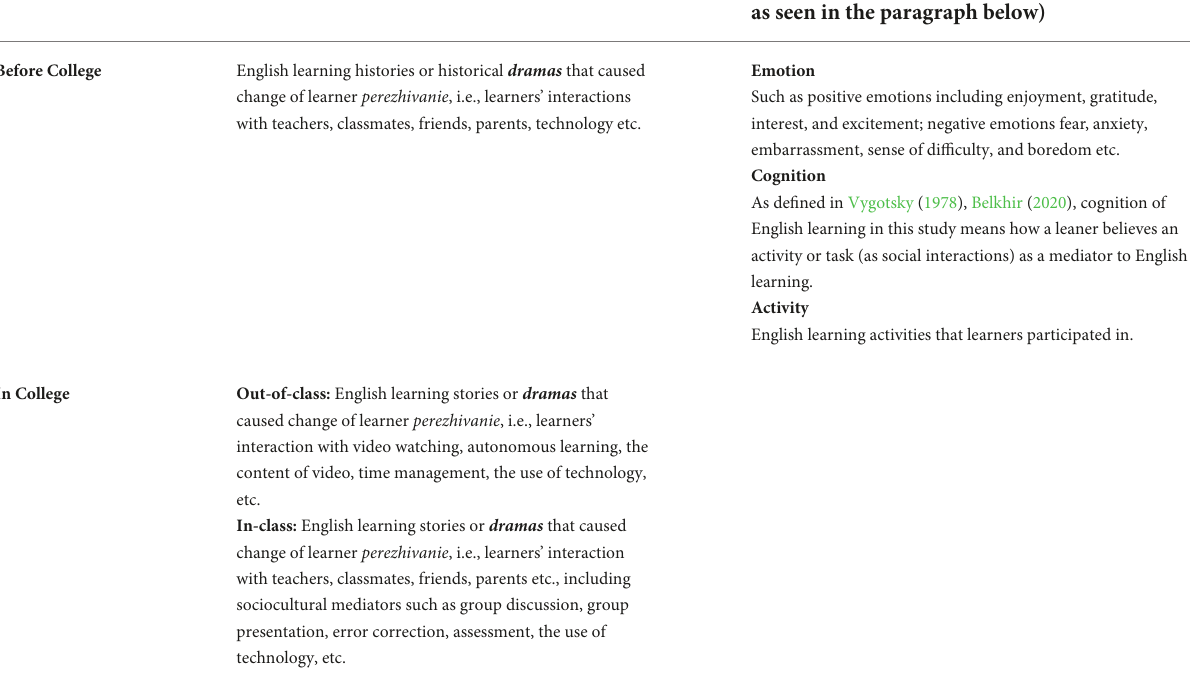
TABLE 3 Coding scheme of the analysis of leaners’ written narratives. Time and